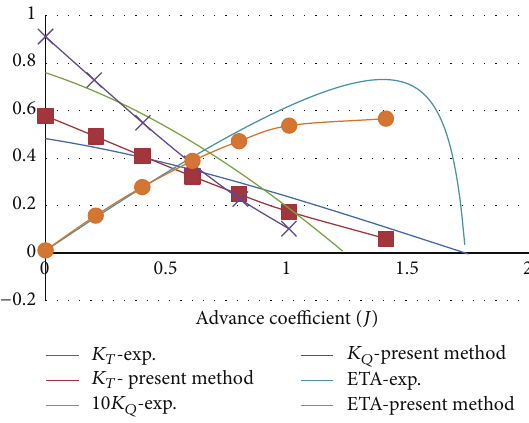
Figure 6: Hydrodynamic coefficient of the investigated propeller with 𝑃/𝐷 = 1.1 .